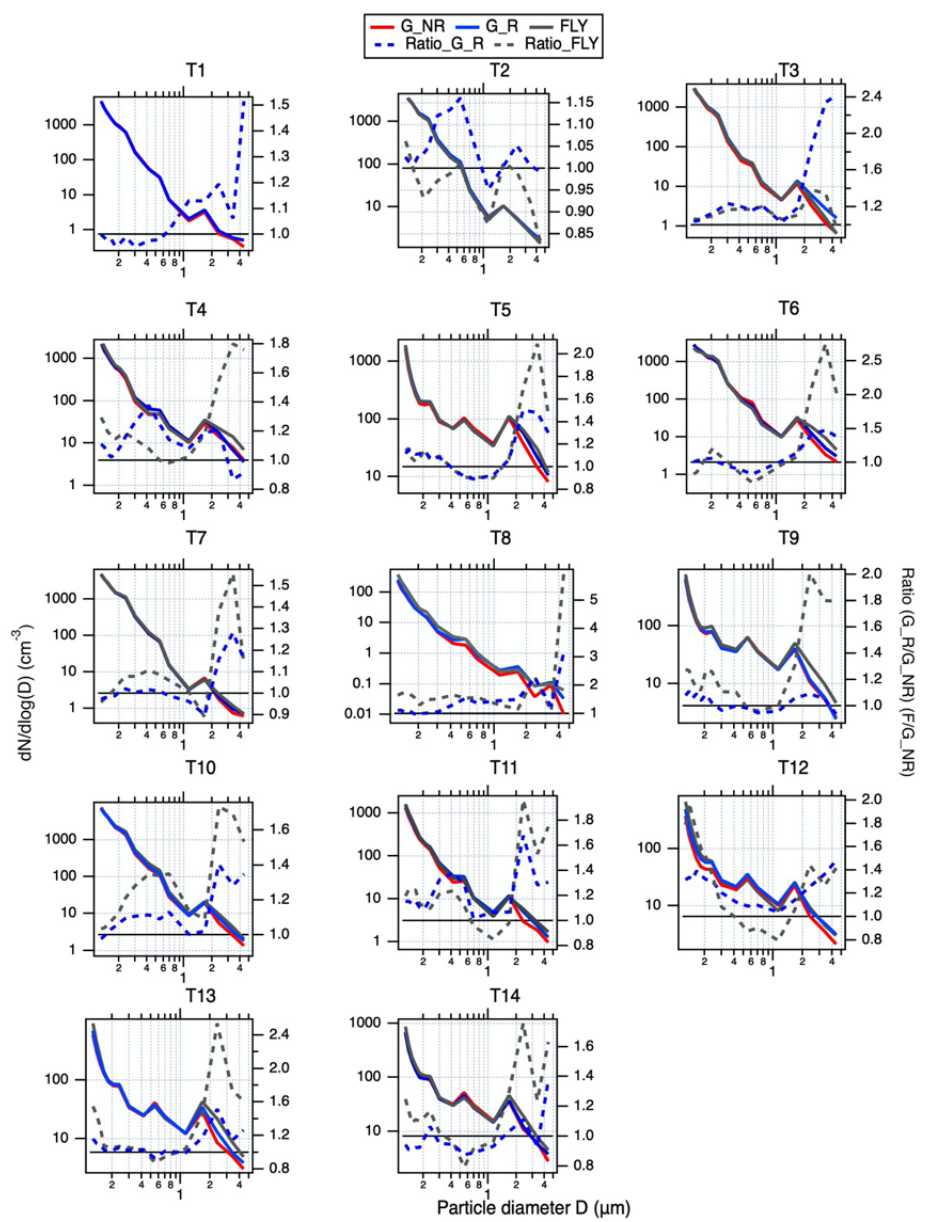
Figure 5. Particle size distribution at three stages: the drone on the ground with rotors off (G_NR) (red line), on the ground with rotors on (G_R) (blue line), and flying at 10m (FLY) (grey line), in each POPS test. The ratios of the PSD at G_R to G_NR (blue dash line) and at FLY to G_NR (grey dash line) of each flight are given in each